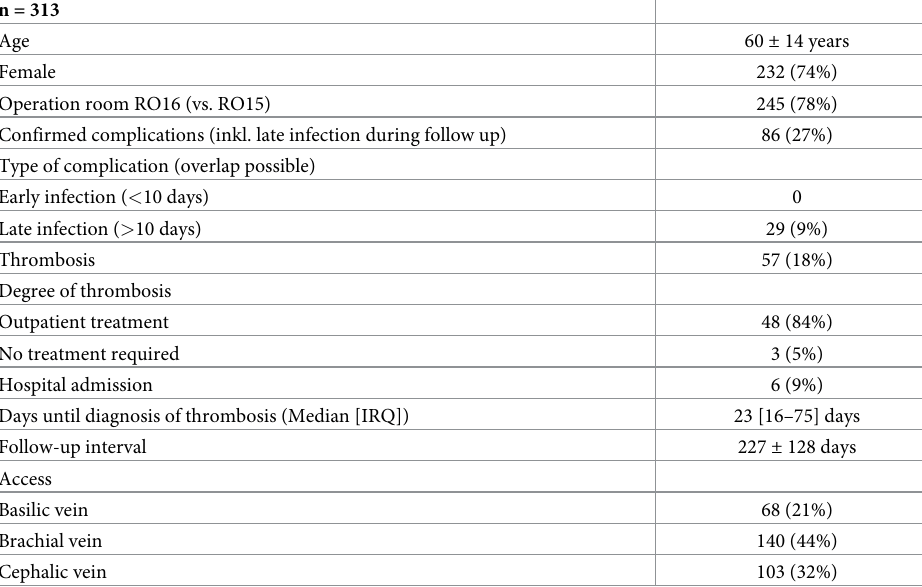
Table 1. The most important clinical parameters of the study